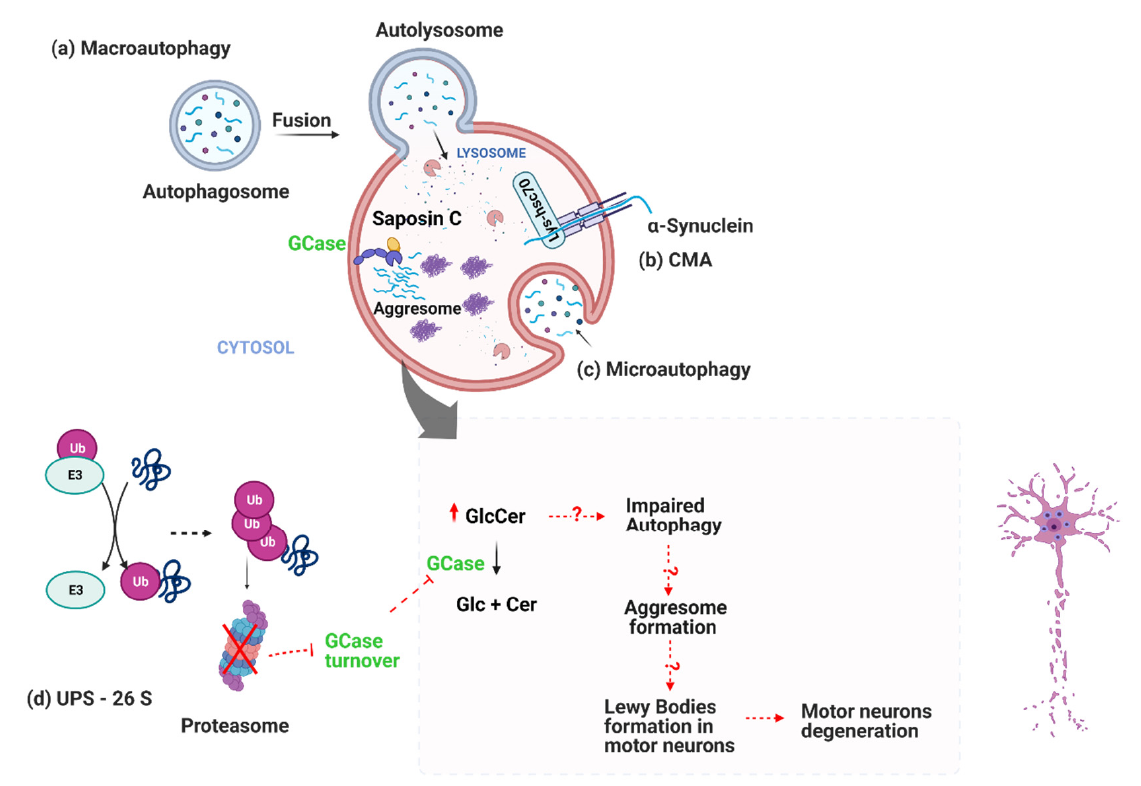
Figure 1. Disrupted protein clearance systems (autophagy-lysosome pathway and ubiquitin-proteasome pathway) in PD motor neurons and GCase dysfunction. ( a ) Macroautophagy. ( b ) Chaperone mediated autophagy (CMA) is a more selective process and targets KFERQ amino-acid-motif containing proteins such as α Syn. ( c ) Microautophagy or pinocytosis of intracellular contents. ( d ) Defective ubiquitin-proteasome system (UPS) failure in eliminating misfolded proteins tagged with ubiquitin such as GCase precede aggresome formation and neurodegeneration. Defects in GCase turnover [46] lead to glucosylceramide (GlcCer) accumulation, which later contributes to α Syn aggregation and impaired autophagy [25]. Altogether, impaired protein-clearance systems cause neurodegeneration in PD (created with BioRender.com. accessed on 1 January 2022). Events leading to GCase dysfunction and its consequences are indicated by red-color arrows. Dashed arrows represent a series of reactions, and dashed arrows with the question mark in the middle indicate unknown mechanisms.